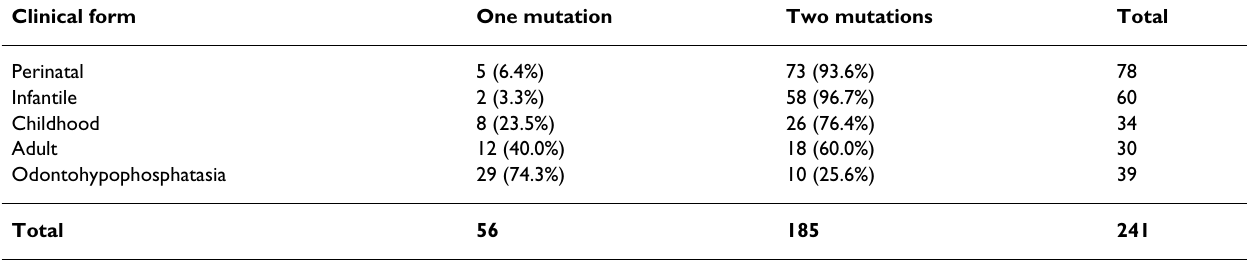
Table 1: Detection rate of ALPL mutations in the patients according to their clinical form Clinical form